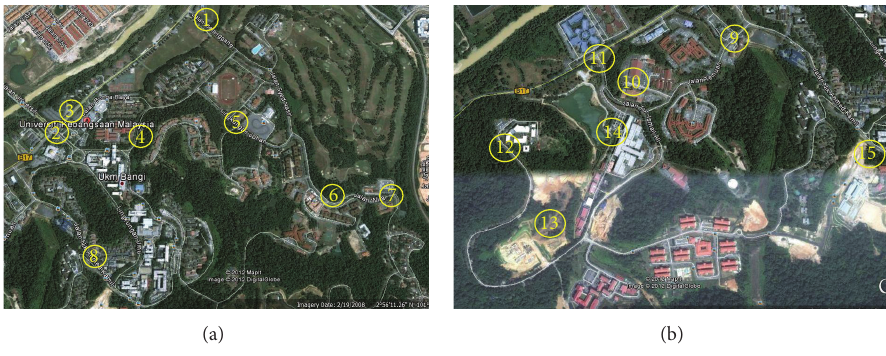
Figure 3: (a) Loop 1 and (b) Loop 2 of UKM campus.